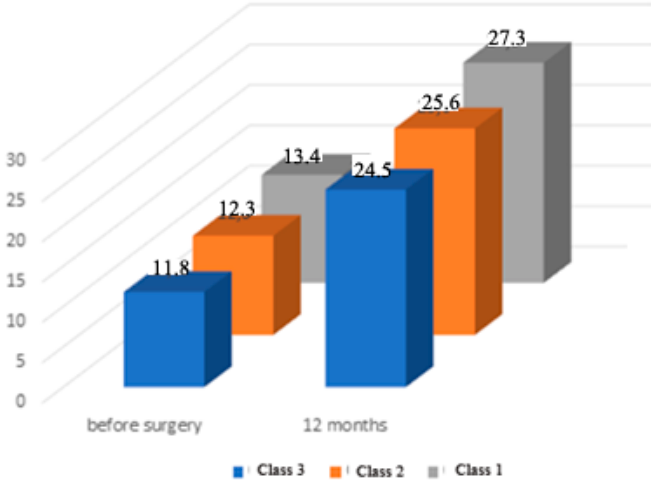
Figure 5. Stage 2—Physical functioning before and 12 months after surgery.